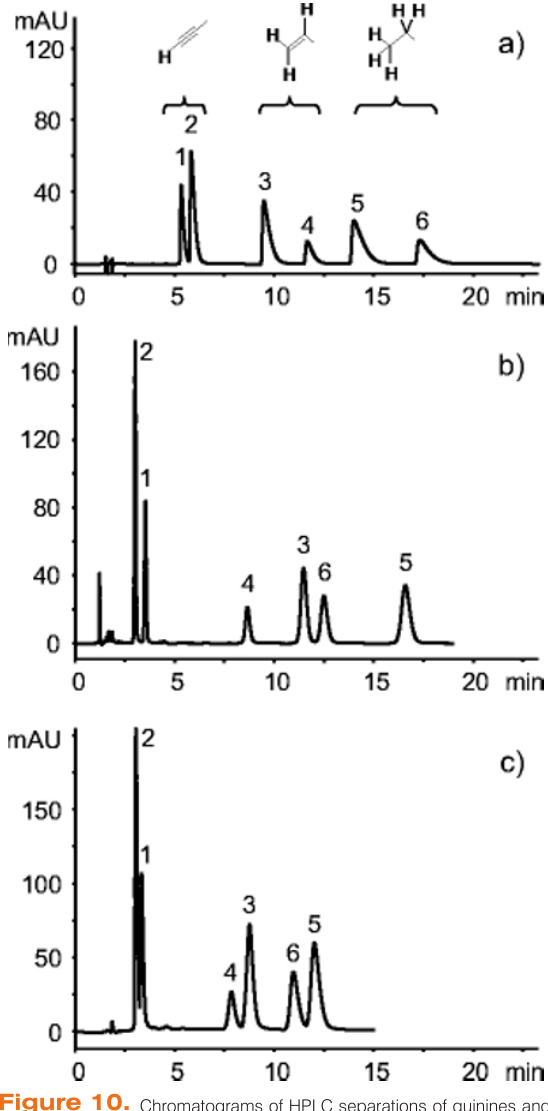
Figure 10. Chromatograms of HPLC separations of quinines and quinidines on different stationary phases: a RP, b cSCX, c PSE-A. Didehydroquinidine (1), Didehydroquinine (2), Quinidine (3), Quinine (4), Dihydroquinidine (5), Dihydroquinine(6). Eluents: 5% ACN in water, 0.1% FA (RP), 37.5 mM NH OAc in MeOH (cSCX), 12.5 mM 4 NH OAc in MeOH (PSE-A). UV detection at 254 nm 4